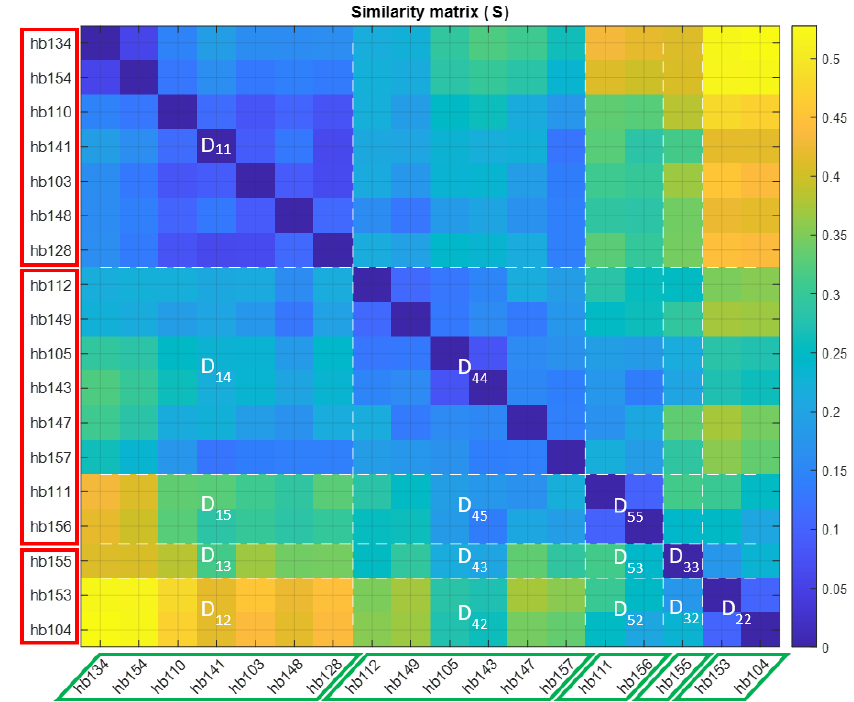
Figure 7. Similarity matrix ( S ) for the suburban environment on the weekday. White dashed lines separate the Q = 5 clustering solution, which in turn also includes the optimal Q = 2 solution. Q = 5 clusters are also highlighted at the bottom by means of green rhomboids and Q = 2 clusters on the left-side with red rectangles. Inter ( i = j ) and intra-cluster ( i (cid:54) = j ) distances are highlighted in white and denoted as D ij .